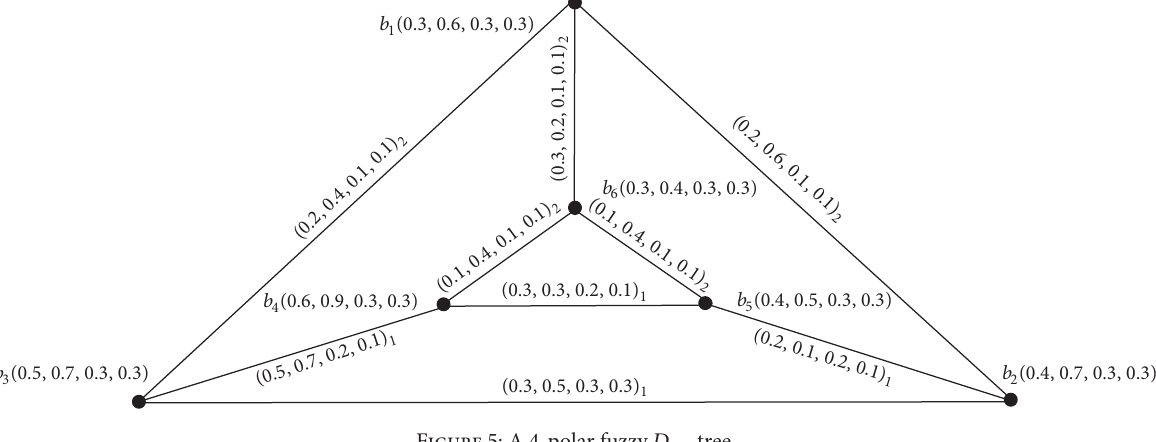
Figure 5: A 4-polar fuzzy 𝐷 1,1 -tree.